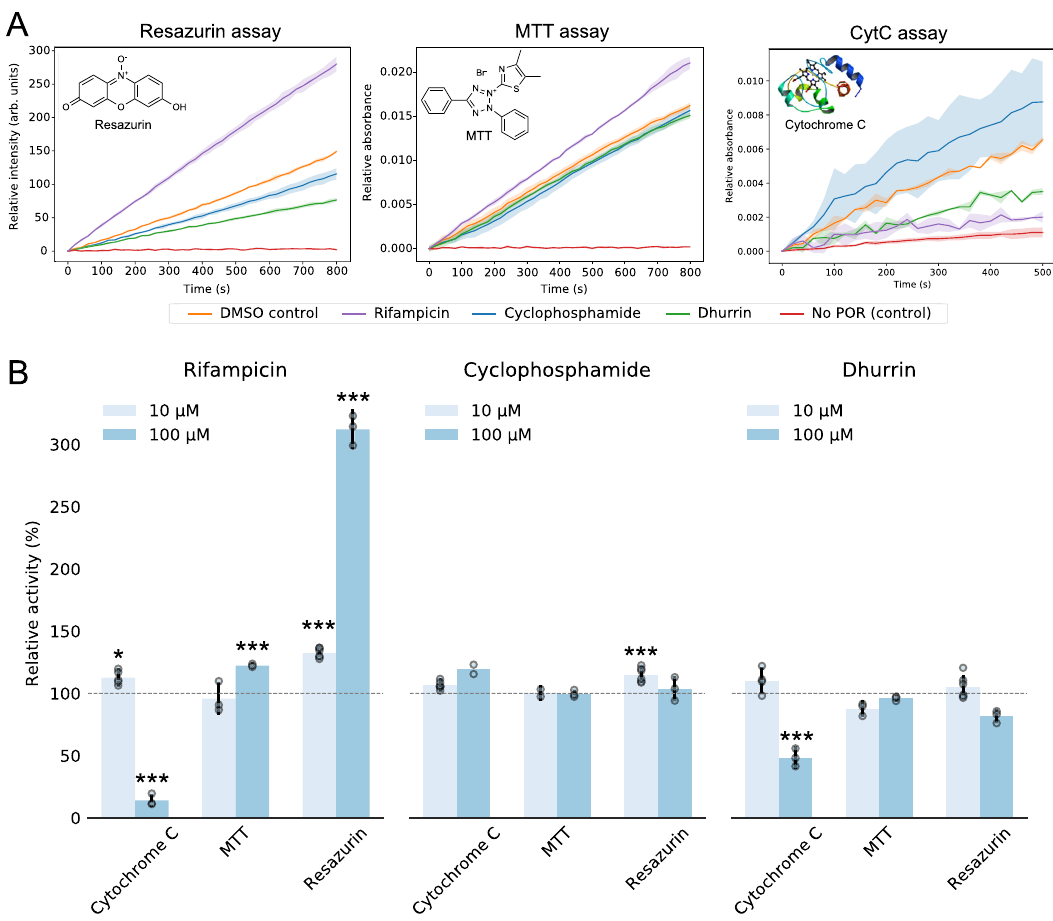
Fig. 2 Small-molecule ligands bias speci fi city of human POR to reduce diverse electron acceptors. A Human POR proteoliposome activity to reduce diverse electron acceptors was assessed using 100 μ M NADPH and 10 μ M RS (left), 500 μ M MTT (middle) or 40 μ M Cyt c (right) by monitoring changes in absorbance (550 nm for Cyt c , 610 nm for MTT) or fl uorescence (582 nm for RS). Note the increased noise due to less sensitive UV – VIS readout for Cyt c . All activity traces depict the mean ± SD of at least three independent measurements. POR activity was extracted by fi tting the linear region of the traces. B Ligands affect the electron donating capacity of human POR differentially dependent on the electron acceptor indicating biased speci fi city. Rifampicin reduces POR activity towards Cyt c , has a small effect on MTT reduction and enhances POR activity to reduce the electron acceptor resazurin by 3-fold. Cyclophosphamide results in minute increased activity towards Cyt c , while dhurrin reduces activity towards Cyt c . The bar plot represents the mean ± SD of independent replicates normalized to DMSO controls with propagated error ( n = 2 – 6; see Supplementary Methods and Supplementary Table 3 for exact value of n for each experimental condition). Note, overlapping data points appear shaded. Data for Cyt c from Fig. 1 are included for comparison. All data are corrected for potential ligand photophysical effect (see Supplementary Fig. 7). Level of signi fi cance is determined by one-way ANOVA and Tukey ’ s HSD test correcting for multiple comparisons (* p < 0.05; ** p < 0.01; *** p < 0.005; see Supplementary Material for details). Source data are provided as a Source Data fi